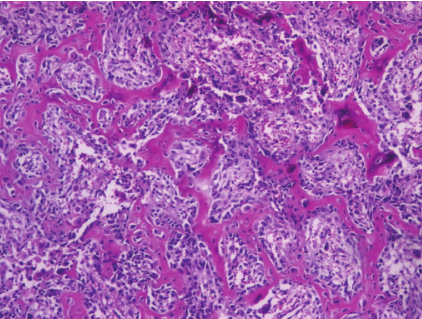
Figure 2: Sharply demarcated tumor composed of anastomosing bony trabeculae surrounded by a loose fibrovascular stroma. H&E ×